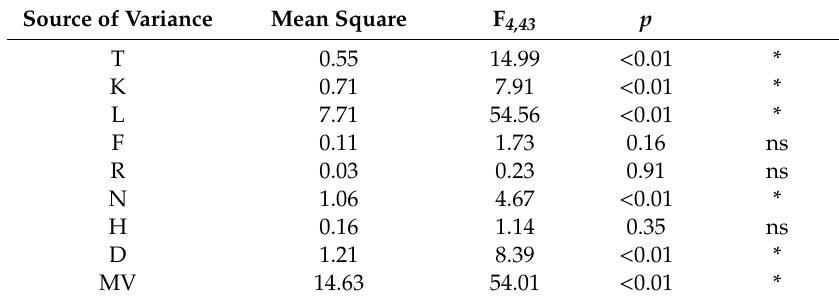
Table 2. One-way ANOVA results of the e ff ect of the vegetation type on ecological indices of Landolt [45]: T, index of temperature; K, index of continentality; L, index of light intensity; F, soil moisture index; R, index of substrate reaction; N, index of nutrients; H, index of humus; D, aeration index; MV, mowing tolerance. Key: *, significant ( p < 0.01); ns, not significant. Source of Variance Mean Square F 4,43 p T 0.55 14.99 < 0.01 * K 0.71 7.91 < 0.01 * L 7.71 54.56 < 0.01 * F 0.11 1.73 0.16 ns R 0.03 0.23 0.91 ns N 1.06 4.67 < 0.01 * H 0.16 1.14 0.35 ns D 1.21 8.39 < 0.01 * MV 14.63 54.01 < 0.01